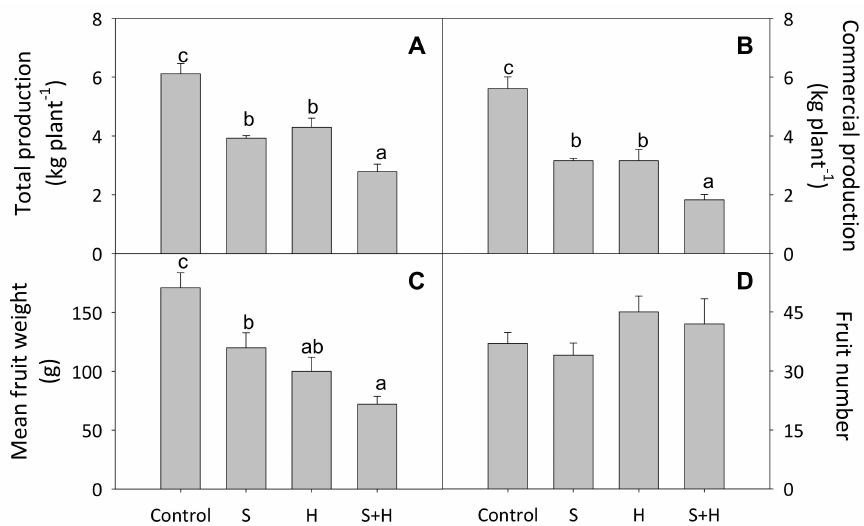
Figure 2. Total production ( A ), commercial production ( B ), fruit mean weight ( C ) and fruit number per plant ( D ) of tomato plants under control (C), saline (S) and heat conditions (H) or the combination of salinity and heat (S + H). Values are means ± SE ( n = 6). Different letters indicate